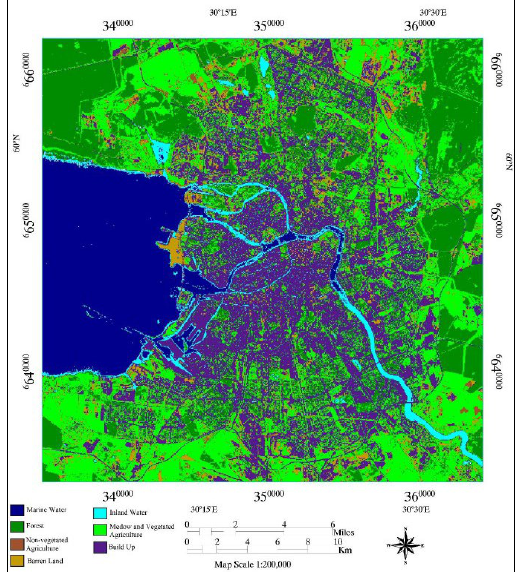
Figure 6. Second-Level Classification